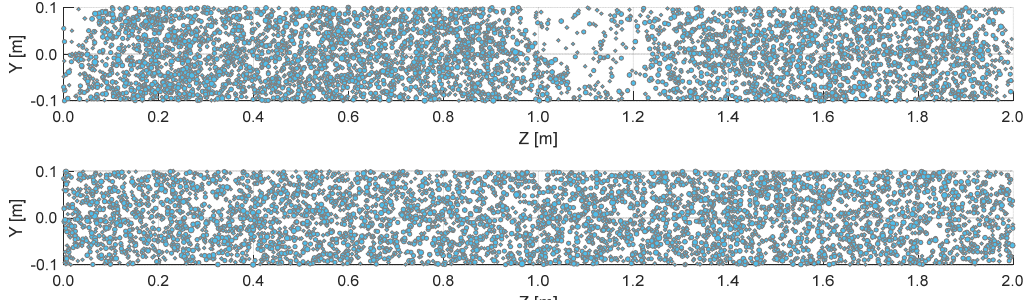
Figure 6. A random selection of 10,000 particles from each of the spatial distributions whose flux results are shown in Figure 7. The representative illustration in the top panel shows LES-positioned droplet locations, with high number density in the first meter and a large void between 1.0 and 1.2 m. The bottom panel shows the same number of particles which have been placed in a uniformly random fashion.